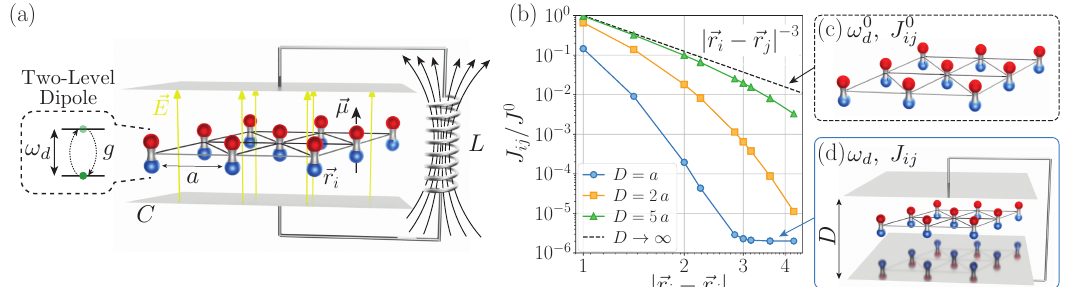
Figure 1: Setup. (a) N anharmonic dipoles with transition dipole moment (cid:126)µ , ar- ⊥ (cid:126)µ and lattice constant a , ranged in a two-dimensional lattice with coordinates (cid:126) r (cid:112) i = 1 / LC and are coupled to a single mode of an LC resonator with frequency ω c (cid:112) L / C (cid:29) Z impedance Z = . The anharmonic dipoles are approximated as two- 0 level systems with transition frequency ω . In such a setup, the coupling parameter (cid:112) d = (cid:126)µ · (cid:126) E / ( ħ h ω ) ∝ α (cid:166) 1 between a single dipole and a single photon, where g /ω c c 0 (cid:126) E is the electric field per photon, can reach values of order unity. (b) The dipole- 0 dipole interactions J depend on the distance D between the metallic plates because ij (cid:12) 3 = J 0 / (cid:12) (cid:12) (cid:126) r − (cid:126) r of screening effects [ see (d) ] , and differ from the bare values J 0 of the (cid:12) i j ij dipole system in free space [ see (c) ] . The screening effects become more important for small D where they strongly reduce the magnitude and range of J ij